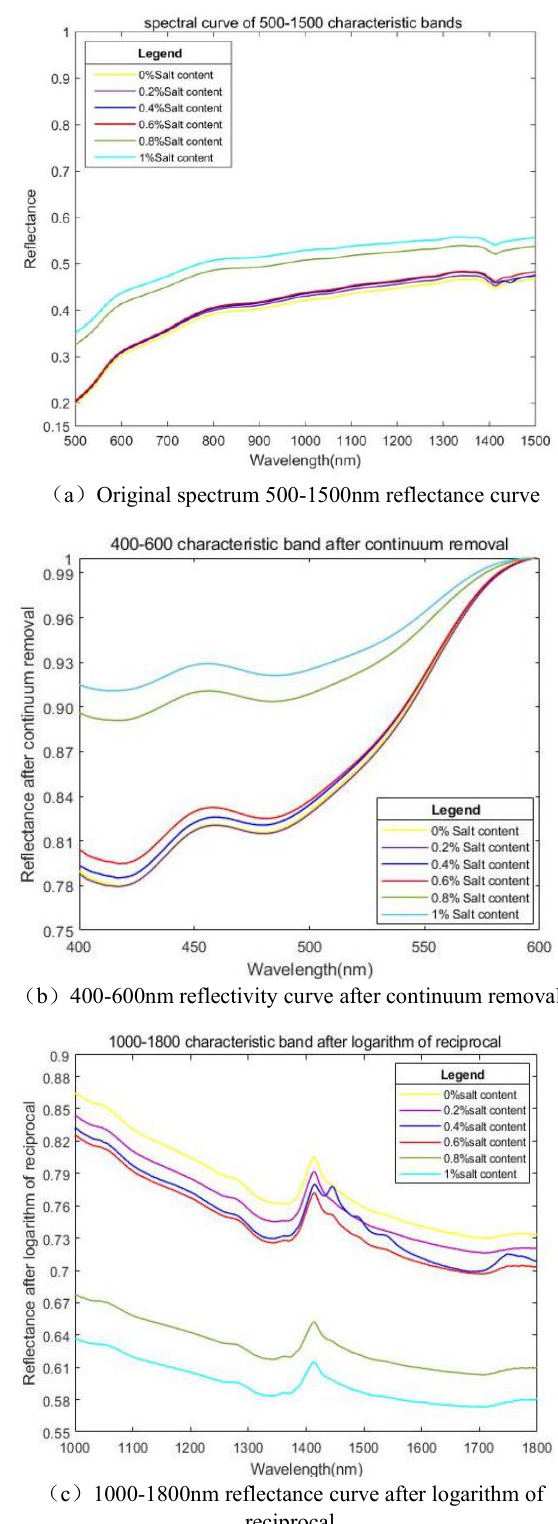
（ c ） 1000-1800nm reflectance curve after logarithm of Figure 4. Spectral curves of characteristic bands under different spectral transformations